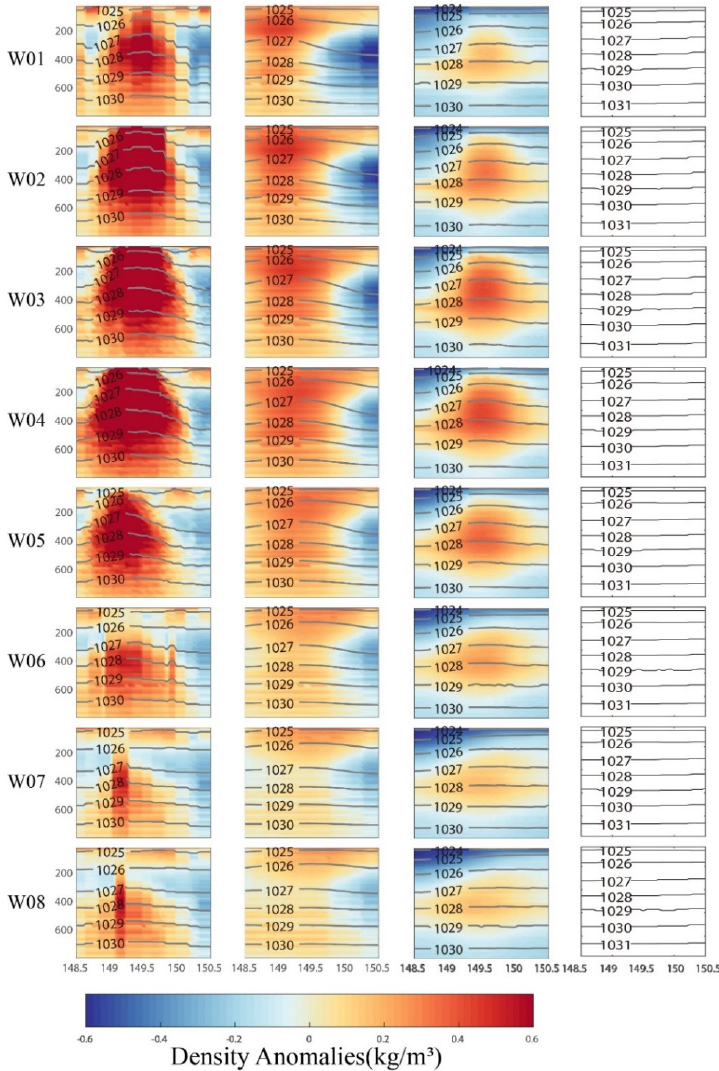
Figure 9. Sectional distributions of density at some specific depth layers. The horizontal axis is longitude and vertical axis is depth. The first column shows the density anomalies measured by MVPs, the second column shows ARMOR 3D density anomalies, and the third column shows the composite eddy density anomalies. The gray lines represent the isopycnal, and the color shading illustrates the density anomalies. The fourth column shows the ARS09 (climatology) density. The color shading illustrates the